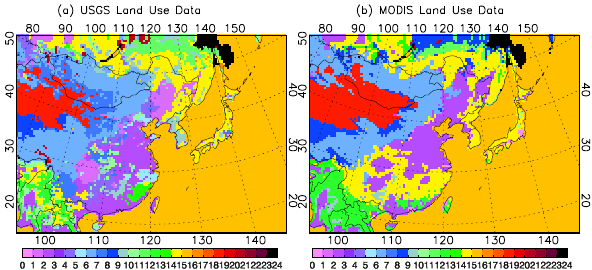
Figure 5. Land-use data from the USGS (left) and MODIS data sets (right). The color-coding scheme used to denote the different sur- face types is consistent for the data sets and follow the USGS data set coloring (Table 4). We used the mapping information (Table 5) to illustrate the MODIS